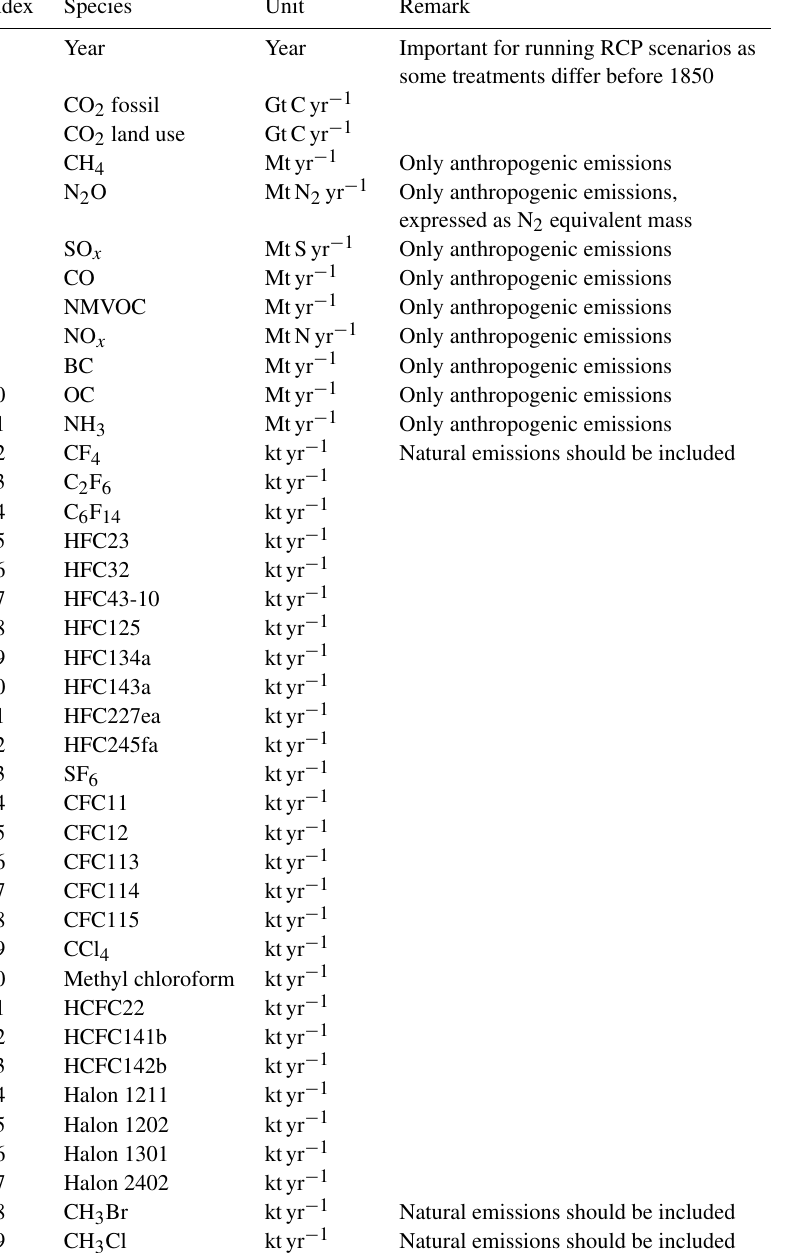
Table 1. Emissions time series input used in FAIR, based on the RCP emissions datasets in Meinshausen et al. (2011b). Index Species Unit Remark Important for running RCP scenarios